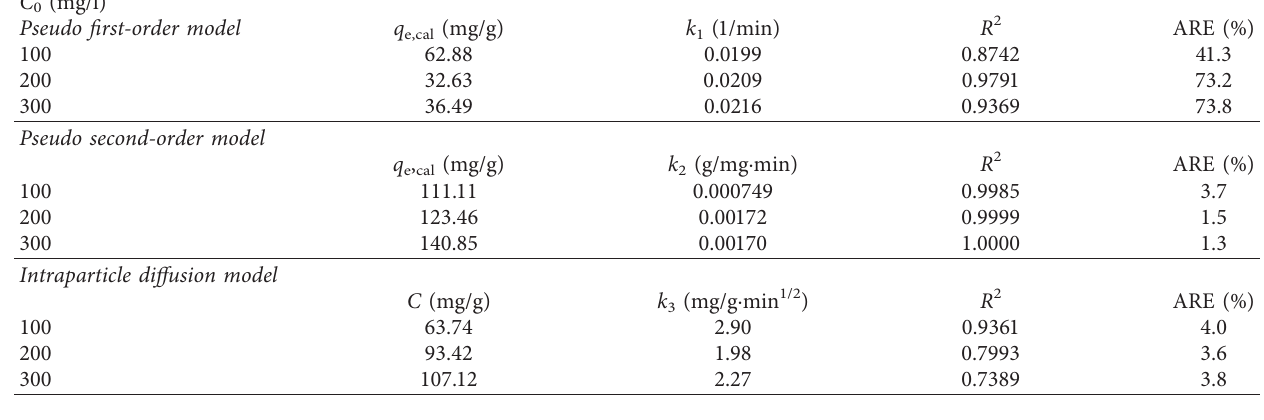
Table 3: Parameters of kinetic models for Cu(II) adsorption onto PAC850-1-3. C 0 (mg/l) Pseudo first-order model